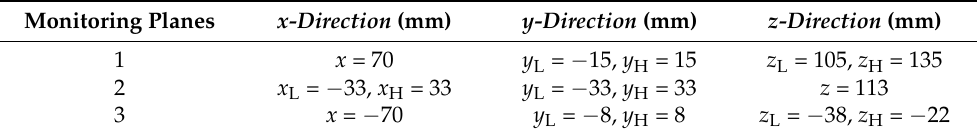
Table 1. Parameters of monitoring plane.